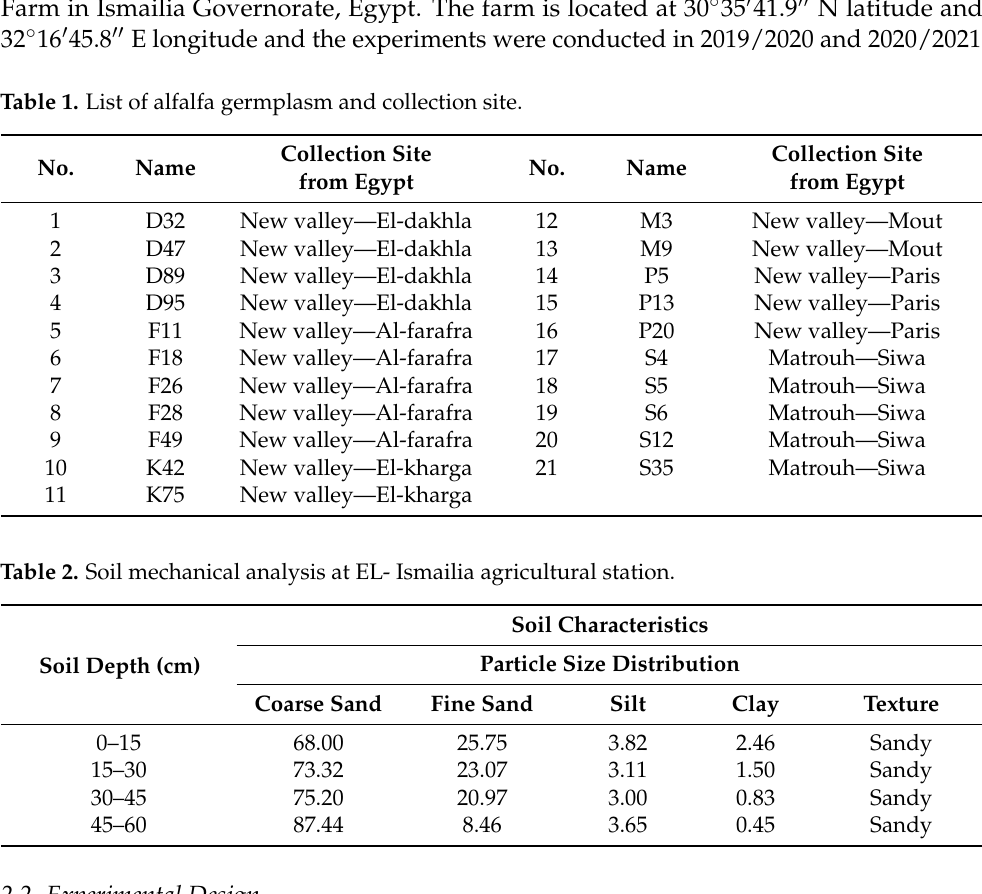
Table 1. List of alfalfa germplasm and collection site.